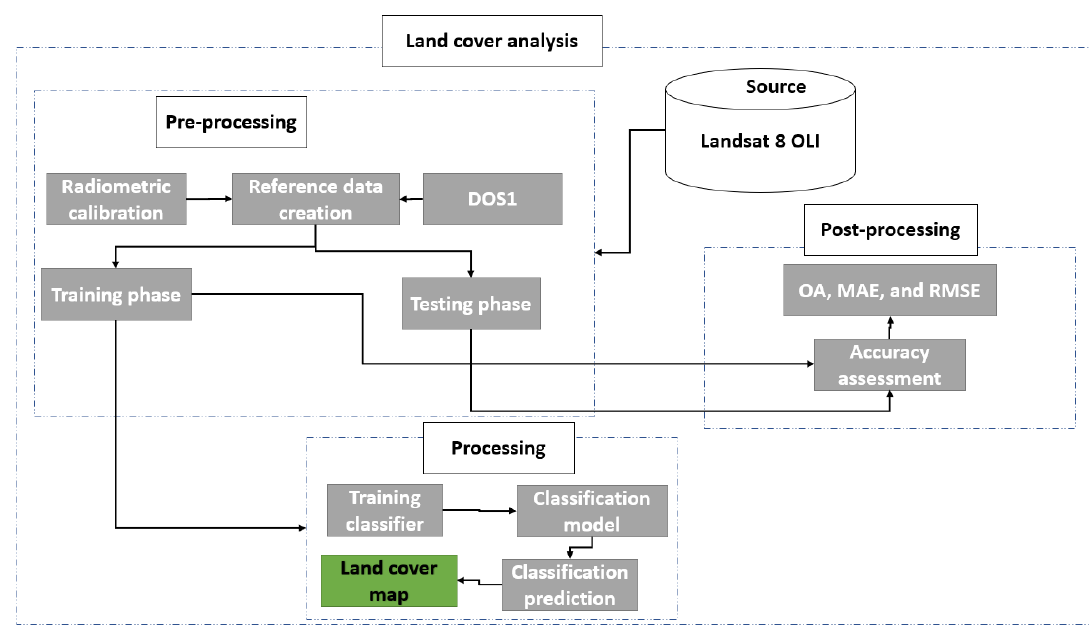
Figure 2. Workflow of this